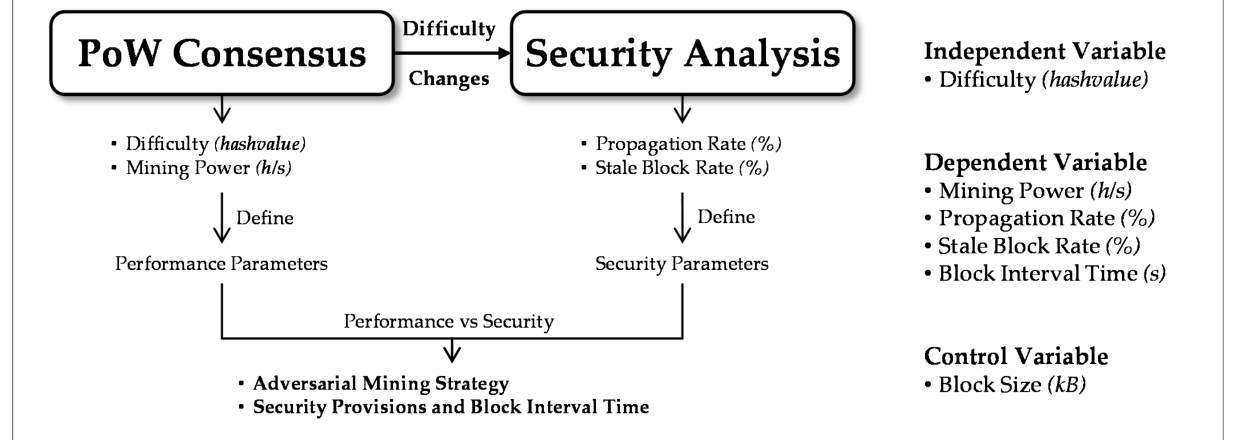
Figure 6. Define Parameters into Two